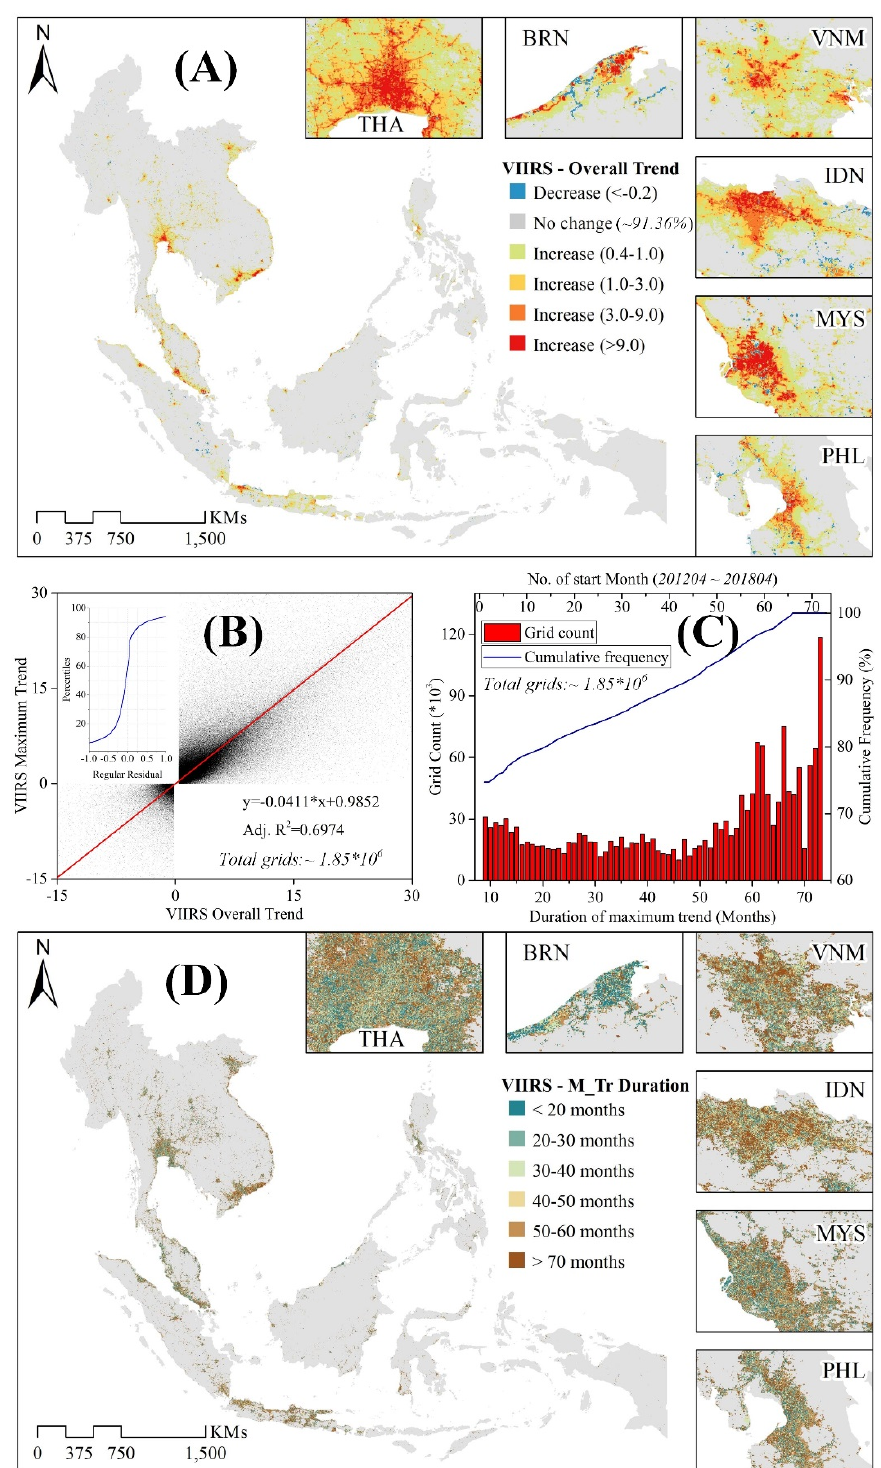
Figure 4. The spatial distribution of the ( A ) VIIRS/DNB overall trend and ( D ) duration of the maximum trend (M_Tr). The statistics also show ( B ) relations between VIIRS/DNB overall trend and maximum trend, and ( C ) histogram of M_Tr duration and cumulative frequency of start month for M_Tr for SEA region for VIIRS change areas (grids count: ≈ 1.85×10 6). Table 3. The average VIIRS/DNB and MODIS/NDVI trend value under the all VIIRS overall trends, positive VIIRS overall trends (>0), and negative VIIRS overall trends (<0) for only VIIRS